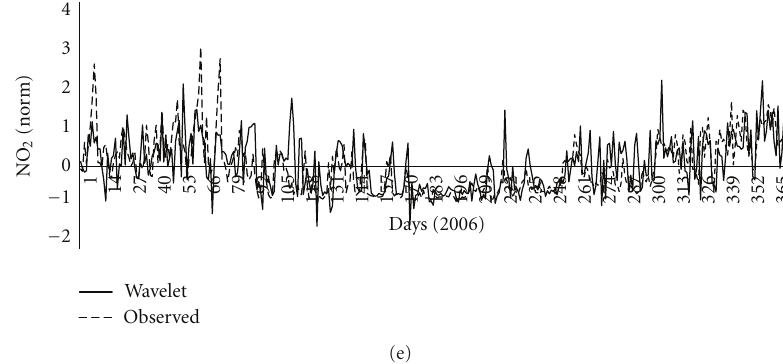
Figure 4: The predicted and observed levels of NO 2 using di ff erent kernel models in 1-year